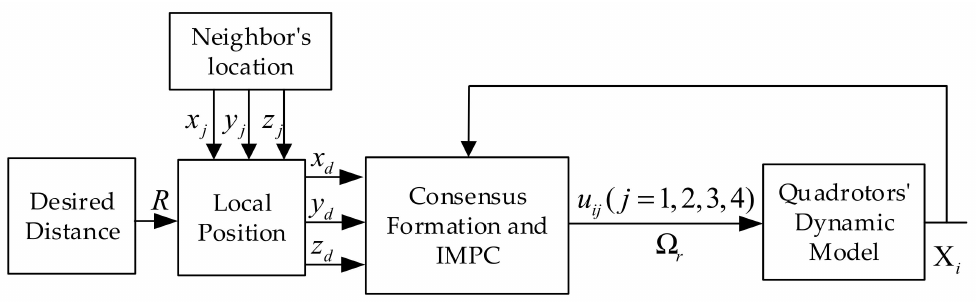
Figure 2. Formation control structure.